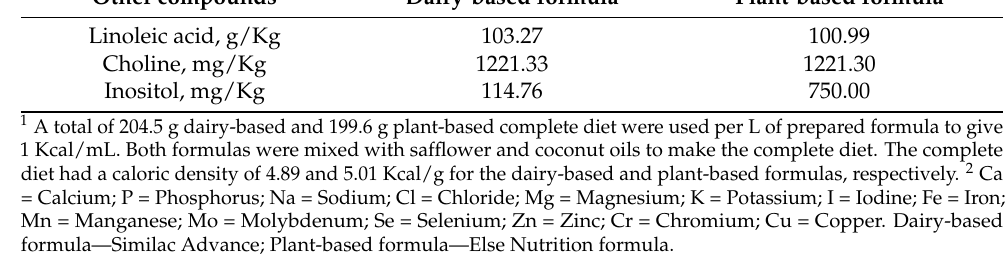
Table 1. Cont. Other compounds Dairy-based